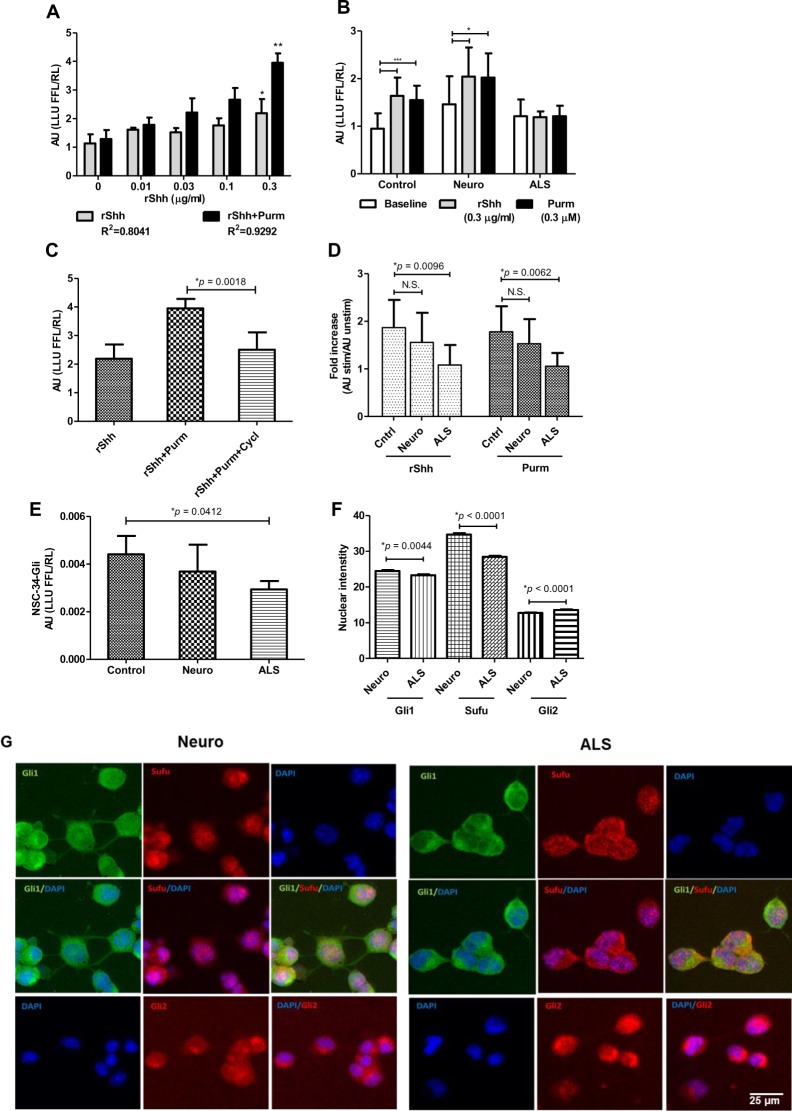
ALS CSF inhibits Shh biological activity in vitro.(A) Standard curves with R2 demonstrate a dose-dependent response of Shh-LTII cells to human recombinant Shh (rShh) and purmorphamine (Purm) (0.3 μM). Shh-LTII cells were cultured with rShh and Purm and developed with Promega Dual-Glo Luciferase Assay System, assaying for firefly (FFL) and Renilla (RL) luciferase-driven luminescence measured as luminescence light unit (LLU). Data are expressed as mean ± SD and shown as arbitrary units (AU) where FFL was normalized to RL (LLU FFL/RL). * and ** indicate significant differences from media alone for rShh and Purm, correspondingly, based on a one way ANOVA analysis with Tukey post-hoc test (p < 0.05). (B) The inhibitory effect of ALS CSF on Shh biological activity measured in Shh-LTII cells is shown. Fully confluent Shh-LTII cells were incubated either with CSF alone, half-diluted with reduced-serum medium as a baseline (white bar), or in the presence of rShh (0.3 μg/ml) (grey bar) or Purm (0.3 μM) (black bar) and assayed with Promega. Data are expressed as mean ± SD and shown as AU. * and *** indicate significant differences between a baseline, rShh, and Purm in neurological controls (Neuro) or normal controls (Controls), respectively, using one way ANOVA with Tukey or Newman-Keuls post-hoc tests (p < 0.05). (C) The inhibitory effect of Shh antagonist cyclopamine (Cycl) is shown in Shh-LTII cells cultured with hrShh and Purm and developed with Promega as described in detail. Data are expressed as mean ± SD and shown as AU with significance value illustrated. (D) The inhibitory effect of ALS CSF shown in (B) is expressed as fold increase over baseline for each sample (AU stimulated/AU unstimulated), demonstrating a significantly increased luminescence in response to rShh and Purm treatment in presence of CSF from controls, but not ALS patients. Data analysis was performed using one way ANOVA with Tukey post-hoc test. Displayed p values indicate significant differences between groups, and N.S. indicates non-significant differences. (E) The inhibitory effect of ALS CSF observed in Shh-LTII cells (B, C) was repeated in NSC-34-Gli cells cultured in half-diluted CSF from controls and ALS patients. Data are expressed as mean ± SD and shown as AU with significance indicated on a graph. (F) Nuclear expression of Gli1, Sufu, and Gli2 proteins is shown in immunofluorescently stained NSC-34-Gli cells cultured for 72 hours in a serum-reduced medium with a half-diluted pooled CSF from Neuro and ALS groups. Data are expressed as mean ± SEM, with significance value included, and shown as a relative nuclear intensity analyzed per cell (ImageJ) over manually contoured nuclear (DAPI) area. Reduced Gli1 and Sufu nuclear translocation in ALS CSF-treated cells are shown, in contrast to elevated Gli2 nuclear expression. (G) Representative immunofluorescence images demonstrating Gli1 (green), Sufu (red), and Gli2 (red) distribution in NSC-34-Gli cells treated either with CSF from neurological controls (Neuro panel) or ALS group (ALS panel) using DAPI (blue) as a nuclear stain. Single or merged images are shown with a scale bar depicted in a bottom right image.